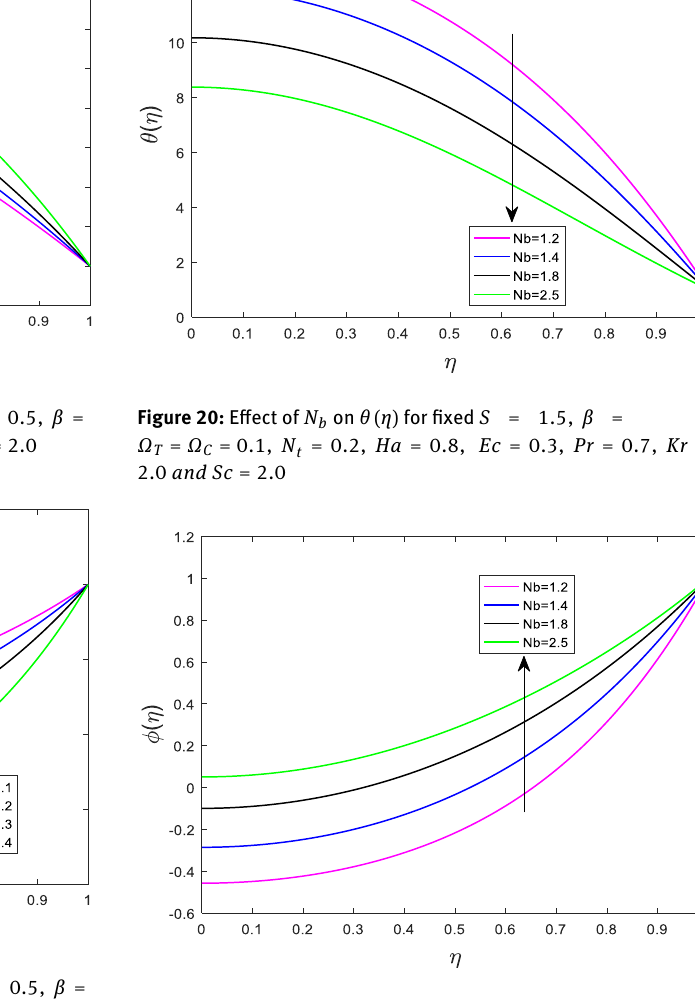
Figure 21: Effect of N b on ϕ ( η ) for fixed S = 1.5, β = Ω T = Ω C = 0.1, N t = 0.2, Ha = 0.8, Ec = 0.3, Pr = 0.7, Kr = 2.0 and Sc =